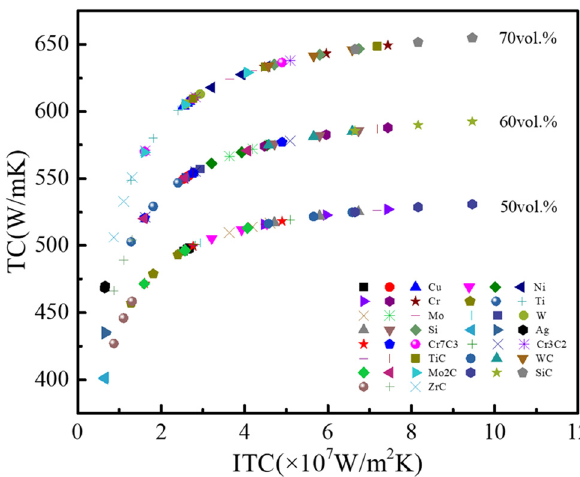
Figure 7: Predicted ITC and TC of 50 – 70 vol% graphite fl akes/Al composites with a coating thickness of 0.2 – 1.0 μ